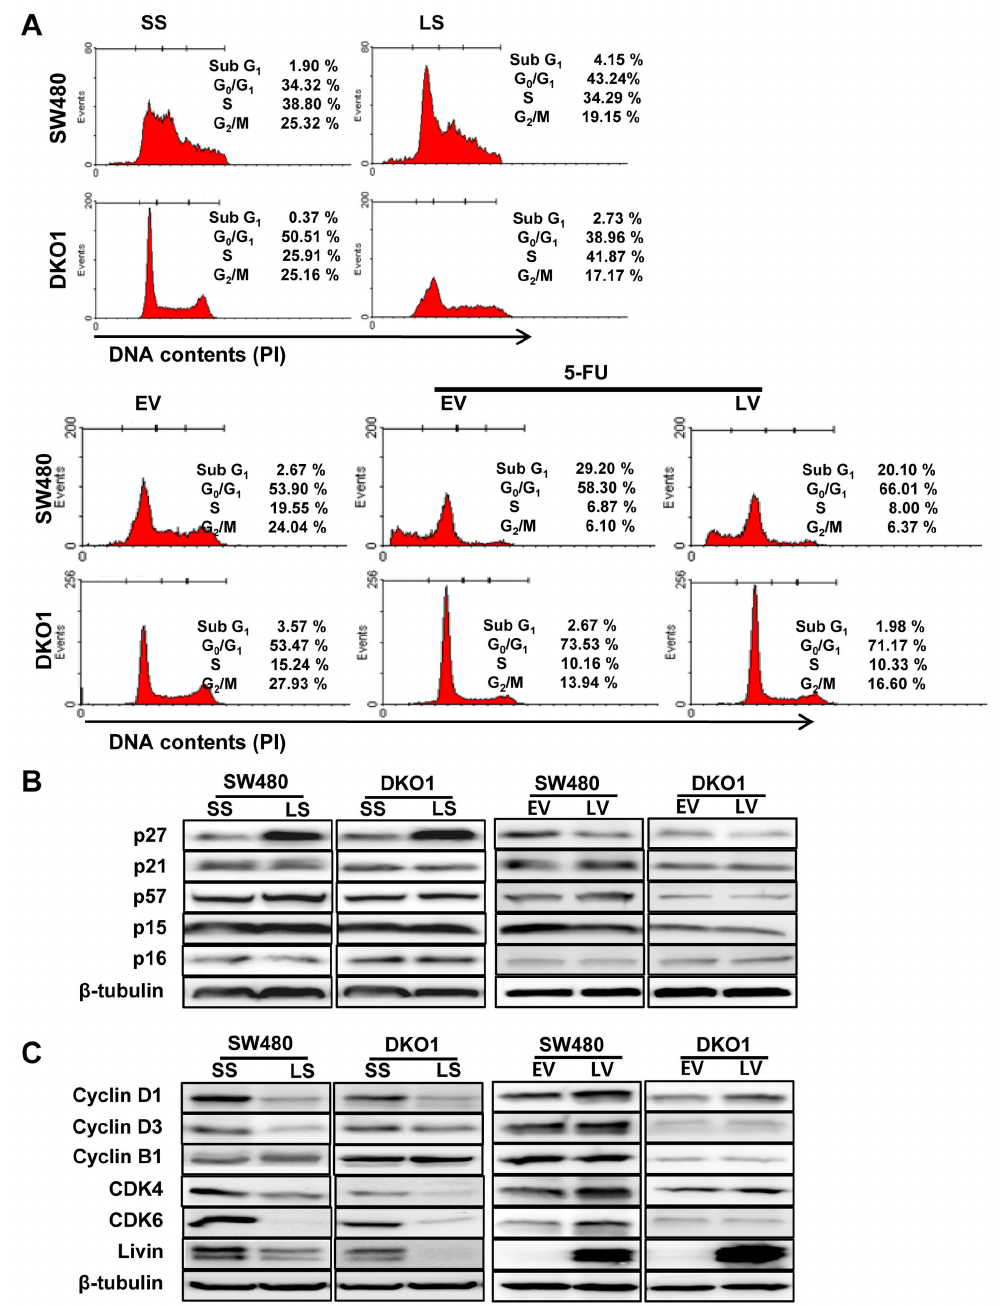
Figure 3. The impact of Livin on cell cycle arrest in human colorectal cancer cells. (A) Livin knockdown resulted in cell cycle arrest in the G0/G1 phase of SW480 cells and the S phase of DKO1 cells. 5-FU treatment induced cell cycle arrest in the subG1 phase of SW480 and the G0/G1 phase of DKO1 cells. Overexpression of Livin inhibited 5-FU-induced cell cycle arrest in SW480 cells and had a minimal influence in DKO1 cells. One representative experiment of the three independent experiments is shown. (B) Expression of cyclin-dependent kinase (CDK) inhibitor proteins. The p27 protein level was significantly increased by Livin knockdown and decreased by overexpression of Livin in SW480 and DKO1 cells. However, p21, p57, p15 and p16 protein levels were not altered in response to knockdown or overexpression of Livin. (C) Expression of cyclins and cyclin-dependent kinase (CDKs) proteins. Cyclin D1, cyclin D3, CDK4 and CDK6 protein levels were significantly decreased by Livin knockdown and increased the cyclin D1 and CDK4 by overexpression of Livin in SW480 and DKO1 cells. SS; scramble siRNA, LS; Livin siRNA, EV; Empty-pcDNA3.1, LV; pcDNA3.1-Livin. doi: 10.1371/journal.pone.0073262.g003 PLOS ONE |